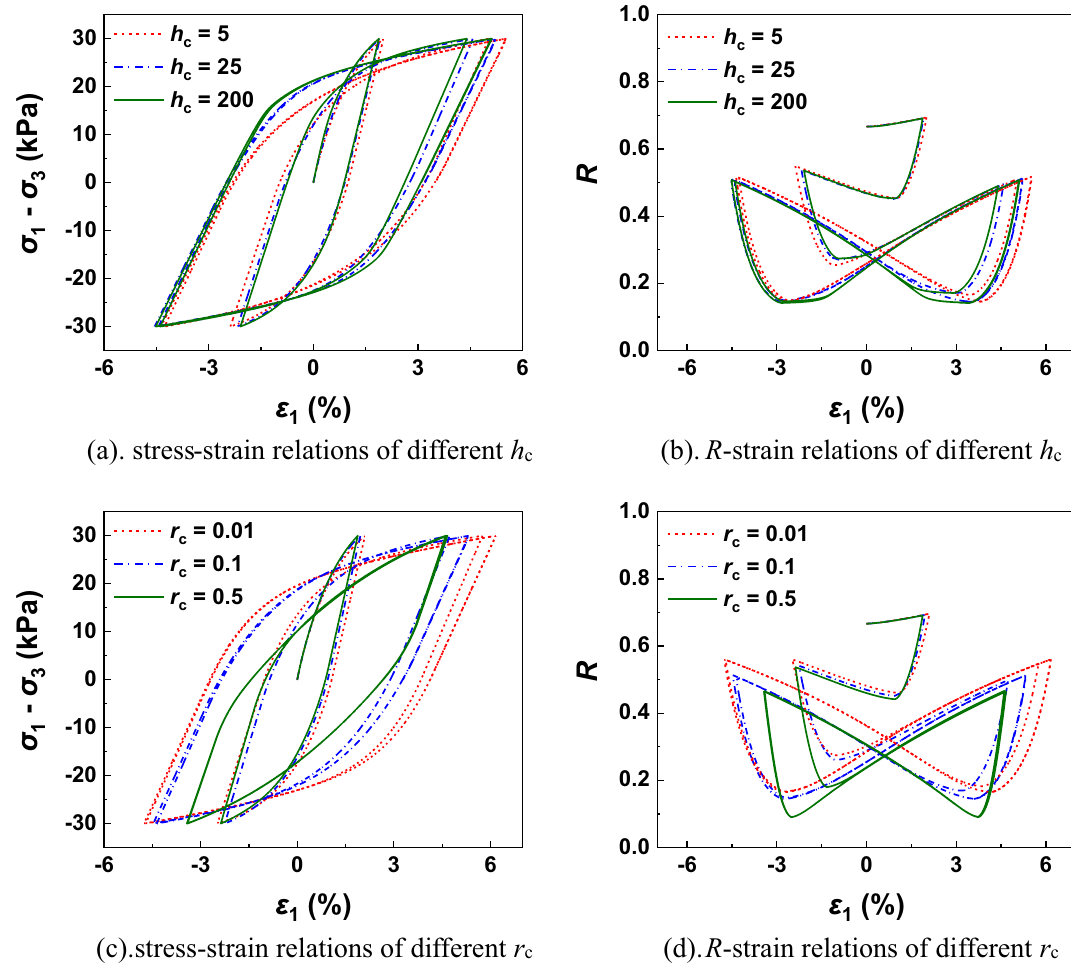
Figure 4. Undrained simulations with different values of h c and r c in cyclic loading